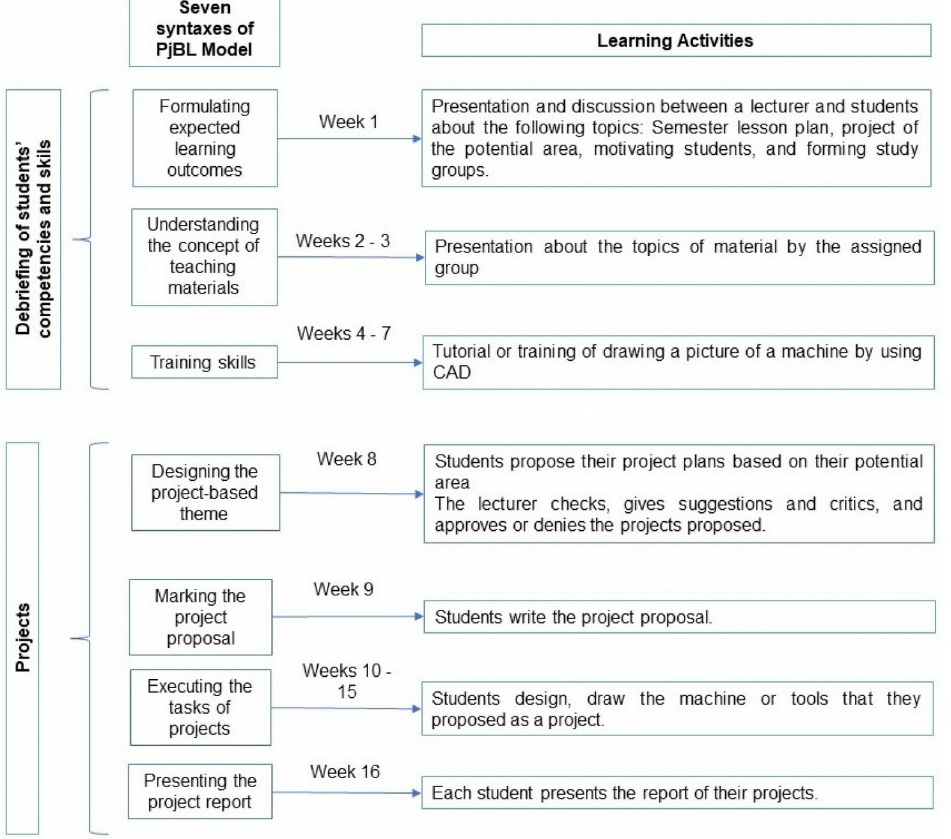
Figure 1. The implementation of the seven syntaxes of PjBL in Mechanical Drawing